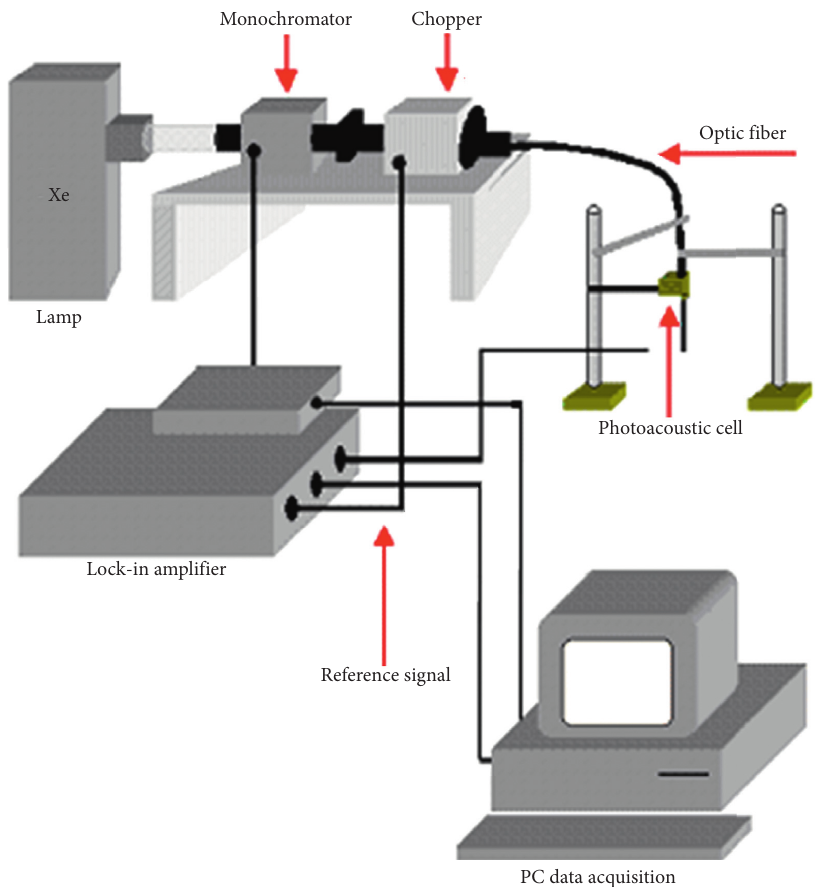
Figure 2: Experimental arrangement for photoacoustic